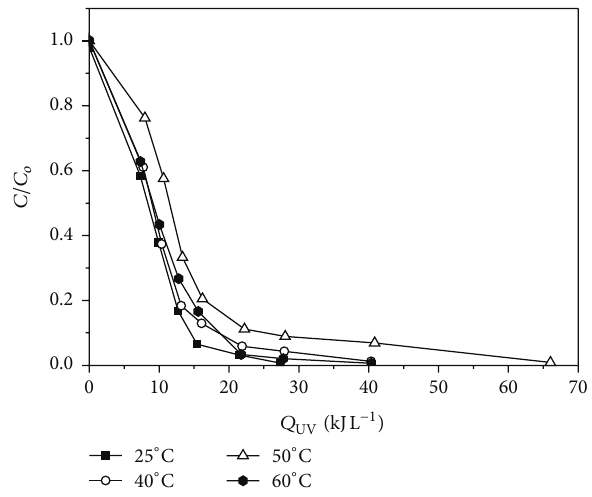
Figure 5: Effect of temperature on decolorization of IC (30mgL −1 ) with 0.1 gL −1 TiO 2 suspensions. Figure 6: Photodegradation of IC (30mgL −1 ) by TiO